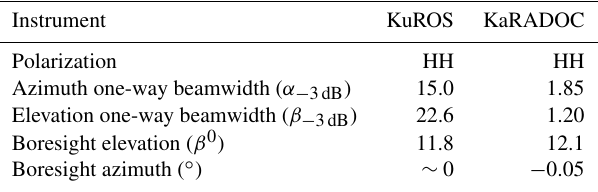
Table 1. KuROS and KaRADOC antenna radiation diagram char- acteristics. All angles are in degrees. See Appendix B for the defi- nitions of α and β .